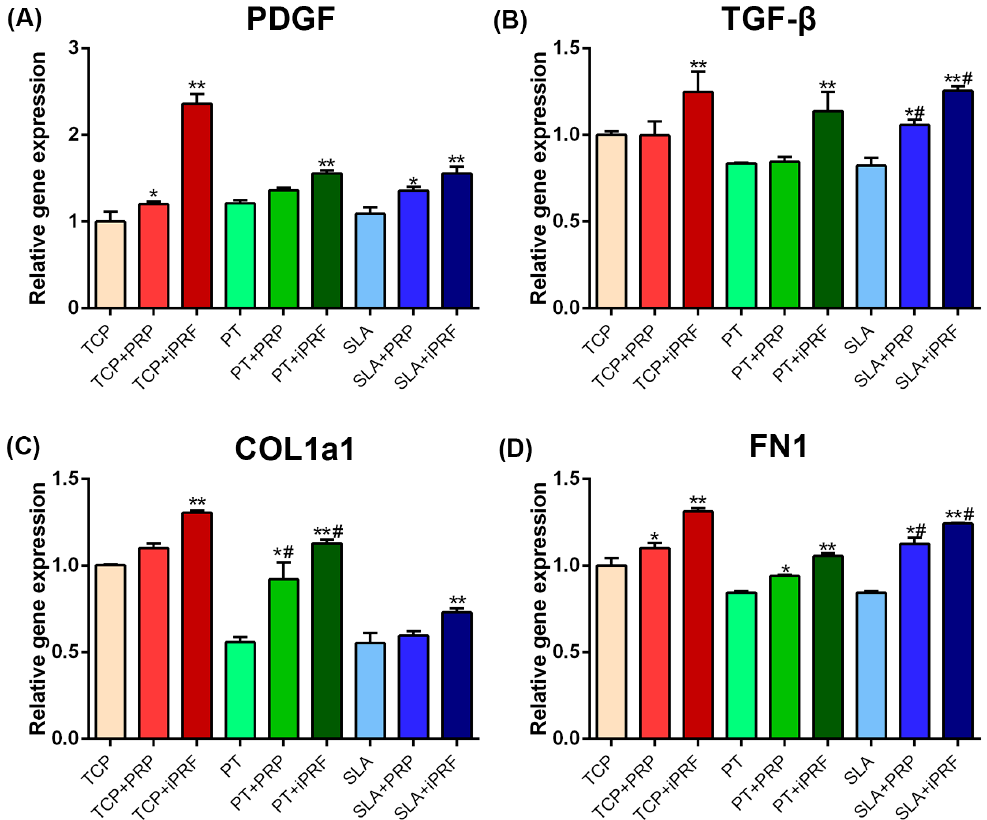
Figure 5. Real-time PCR of human gingival fibroblasts cultured on TCP, PT and SLA, with and without PRP or i-PRF for mRNA levels of ( A ) PDGF ; ( B ) TGF- β ; ( C ) COL1 and ( D ) FN1 . (* denotes significant difference between control and experimental group, p < 0.05; ** denotes significantly higher than all other groups, p < 0.05; # denotes significant difference between PT and SLA surfaces, p < 0.05).